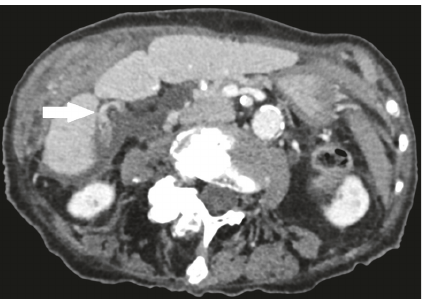
Figure 3: Abdominal contrast enhanced CT scan, portal phase: “Whirl sign” of the gallbladder pedicle.